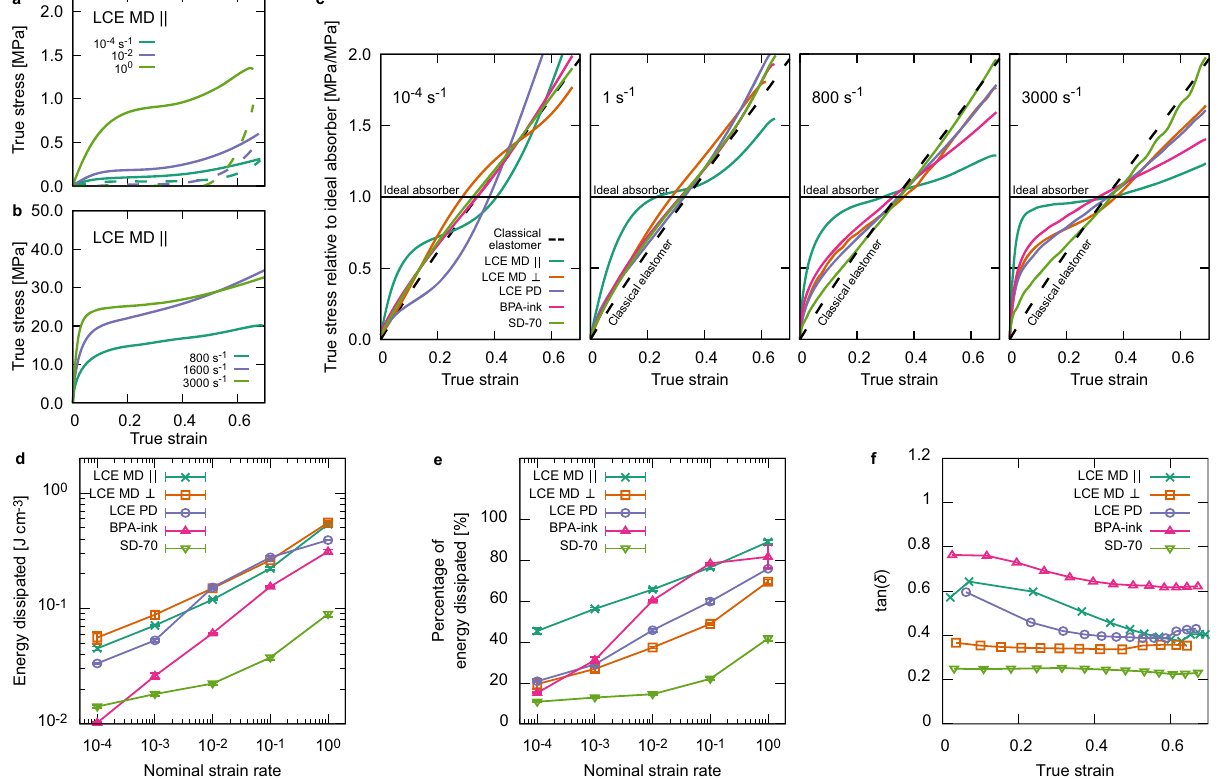
Fig. 3 Strain energy absorption. a Examples of compressive loading (solid) and unloading (dashed) curves for the LCE MD k with nominal strain rates between the quasi-static 10 − 4 s − 1 and the intermediate 10 0 s − 1 demonstrating the rate-dependence of the soft-elastic response. The area between the load curves corresponds to dissipated strain energy. b Examples of impact-rate compressive load curves, measured using a Kolsky (Split Hopkinson) bar, the rate dependency is still evident with the LCE demonstrating stiffer (softer) elastic behaviors at low (intermediate) strains for increasing displacement rate. c Comparisons of each material ’ s compressive behavior at various strain rates relative to the constant-stress behavior of the ideal dissipator of strain energy. For reference, the expected response of a classical entropic elastomer is also shown. Representative curves are shown from a testing size of at least three experiments. d Quanti fi ed measurements of the dissipated energy and ( e ) percentage dissipated energy relative to loaded energy for each tested material from quasistatic 10 − 4 s − 1 , and the intermediate 10 0 s − 1 nominal strain rates. f The loss ratio, tan ( δ ) = E ''/ E ', from small strain (0.1% amplitude) dynamic mechanical analysis tests performed on each sample at different levels of compressive strains. For ( d ) and ( e ) errors represent SD, for ( f ), the SD experimental errors are smaller than the